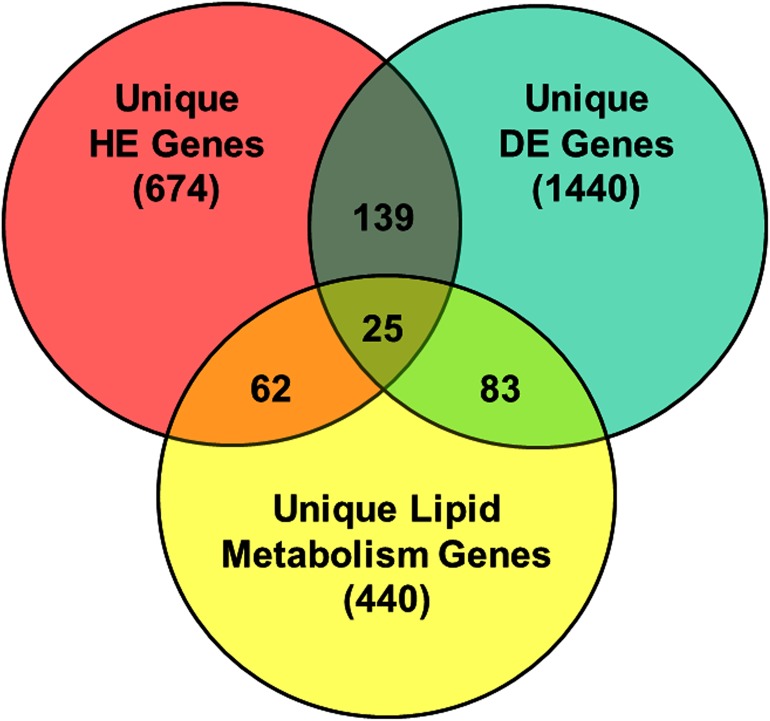
Venn diagram illustrating overlap among functional gene lists.The Venn diagram shows the intersections of highly expressed (HE) genes in abdominal fat (S3 Table), differentially expressed (DE) genes (S4 Table), and Ingenuity annotated genes known to be involved in lipid metabolism (S5 Table). The numbers in overlapping arcs indicate the number of genes shared between and among these three categories.